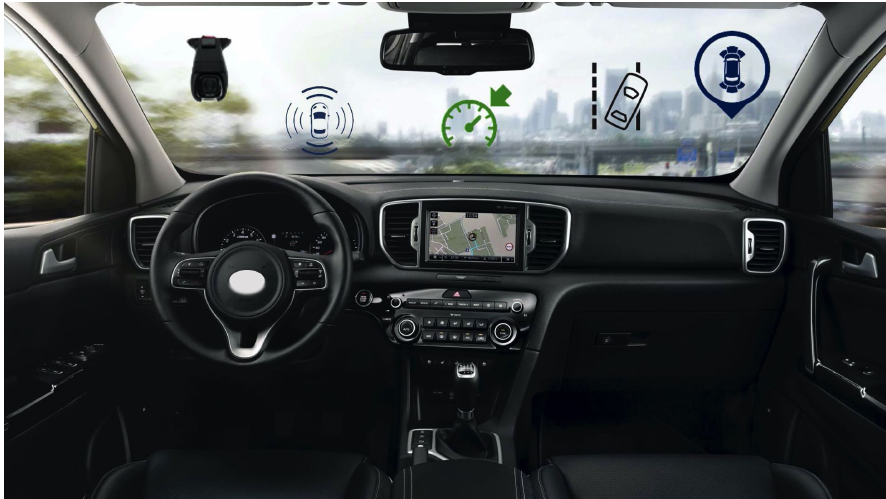
Figure 1. Some examples of ADAS